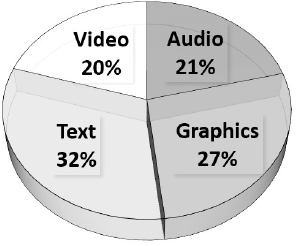
Figure 8. Interactive content type percentage. The figure shows the interactive content type percentage of the 500 users